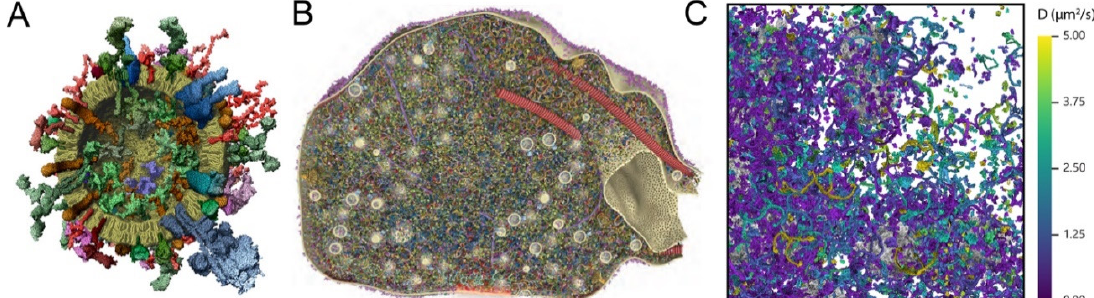
Figure 1. Quantitative synaptic views. ( A ), Molecular view of a synaptic vesicle, in which the different molecules are placed randomly, in copy numbers corresponding to quantitative biochemistry measurements. The large blue molecular complex to the lower right is the proton pump [16]. ( B ), A reproduction of the presynaptic bouton, indicating 60 different proteins, shown at copy numbers determined from quantitative biochemistry on mixed rat cortex and cerebellum synaptosomes, and in positions corresponding to an analysis performed by super-resolution imaging [17]. ( C ), A dynamic view of the presynaptic space. Proteins are shown in their original shapes (same as in ( B )), but color-coded according to their calculated diffusion coefficients. Modified from [33]. For all panels, the synaptic vesicles provide a size scale, as they are 42 nm in diameter (clearly visible in panels ( A ) and ( B ); shown in gray in panel ( C )).